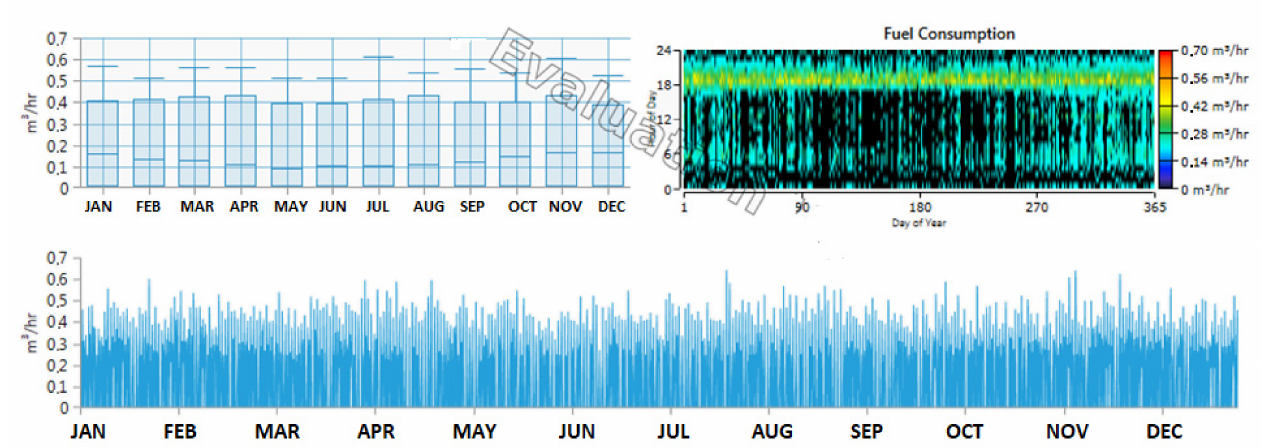
Figure 8. Fuel consumption in the adopted system. Source: own study using Homer Grid